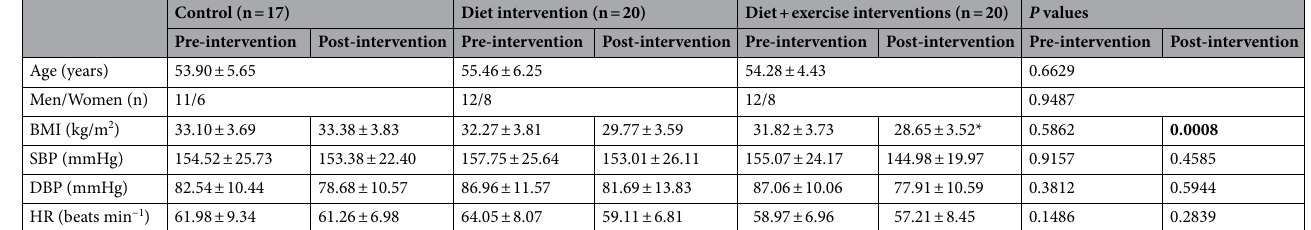
Control (n = 17) Diet intervention (n = 20) Diet + exercise interventions (n = 20) P